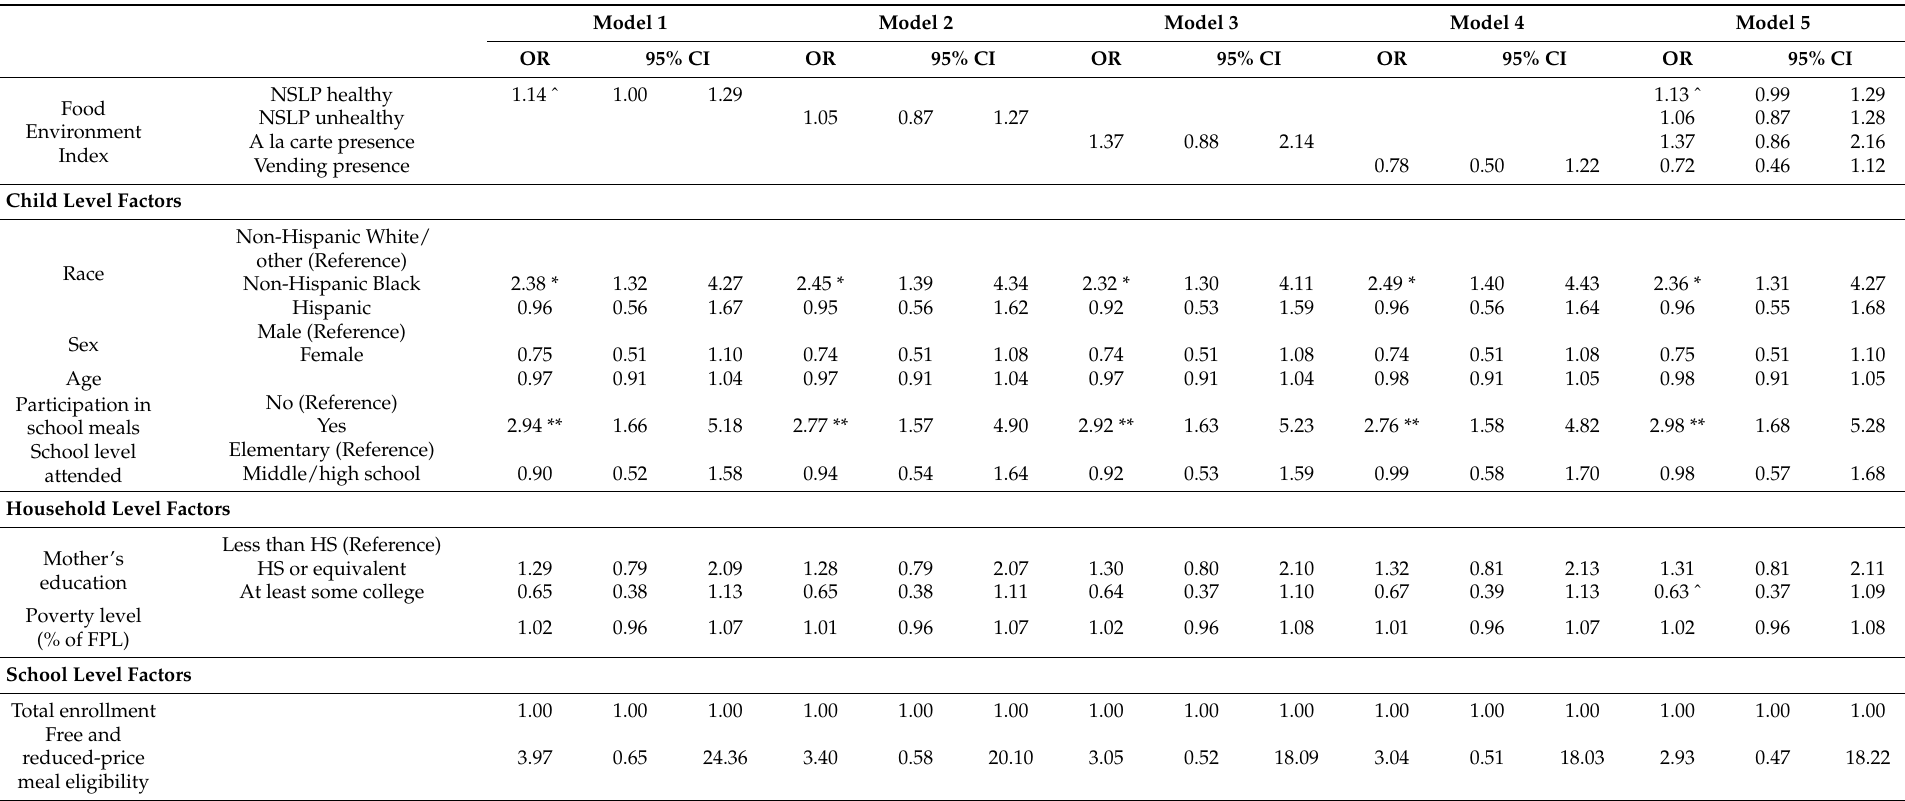
Table 3. Results from multivariable ordinal logistic regression examining the association between parental perceptions and each school food environment measure alone and all together in the